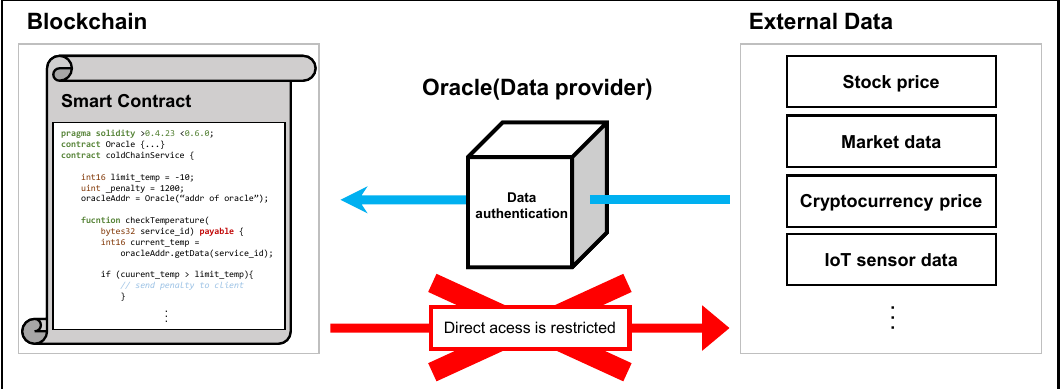
Figure 1. Blockchain Oracle